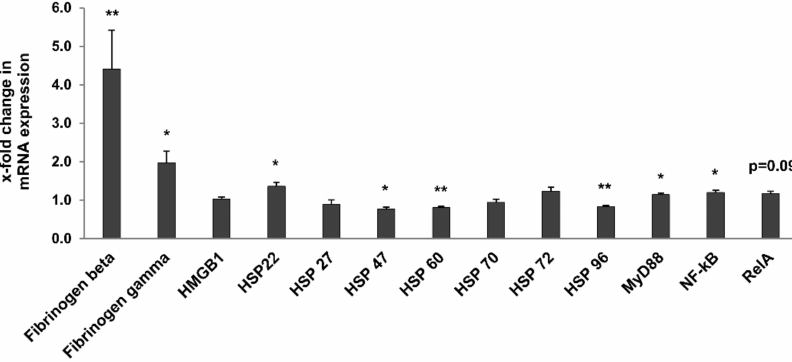
Figure 8. Expression of endogenous TLR ligands and downstream signaling molecules. Data was normalized with respect to the corresponding values determined in 3-month-old rats. p -values ≤ 0.05 and ≤ 0.01 are indicated by one or two asterisks,